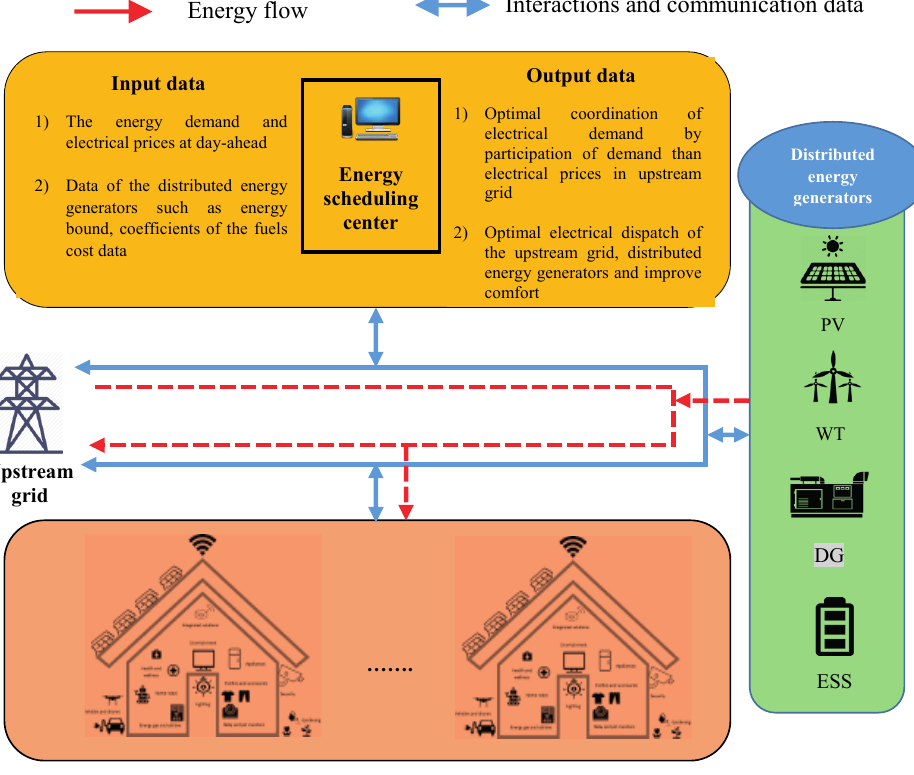
Fig. 1. Overview of smart residential buildings in electrical